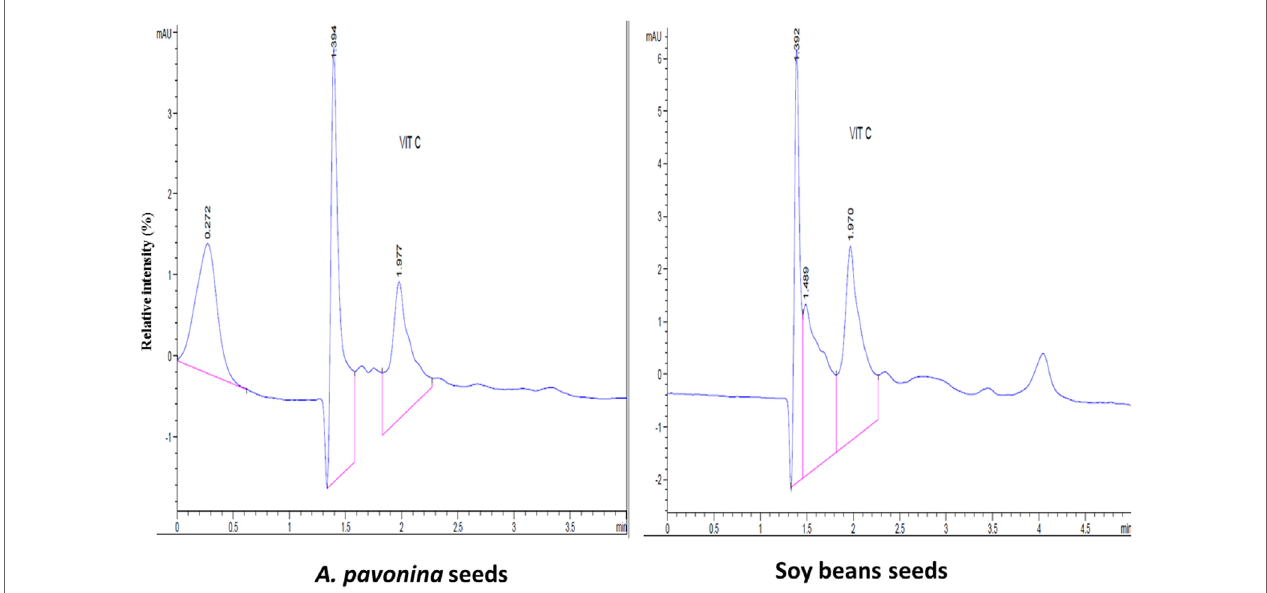
FigUre 2 | Chromatogram for vitamin C in pro-milk extracted from A. pavonina and soy